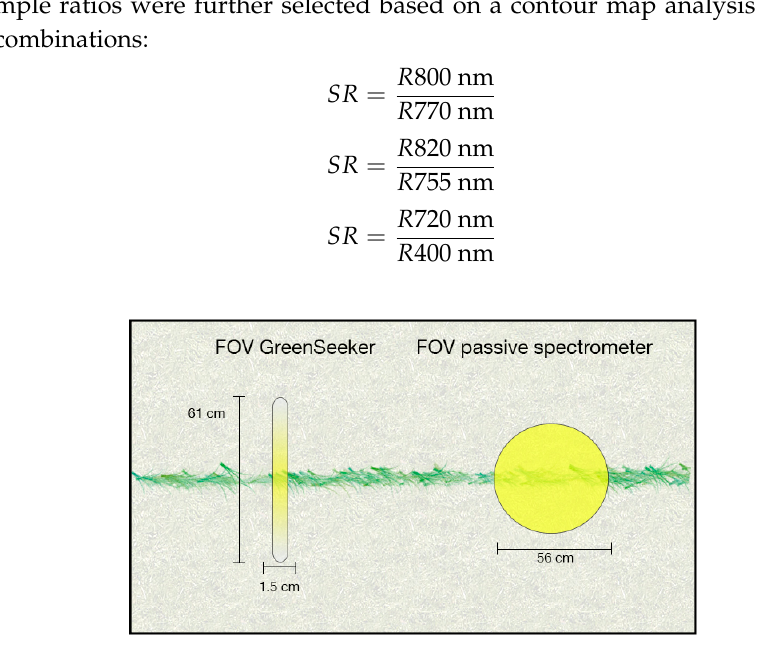
Figure 3. Illustration of different shapes of the sensors’ fields of view (FOV) in single-row trials. Yellow colour indicates decreasing light intensity in the periphery of the LED-based GreenSeeker (unpublished data).